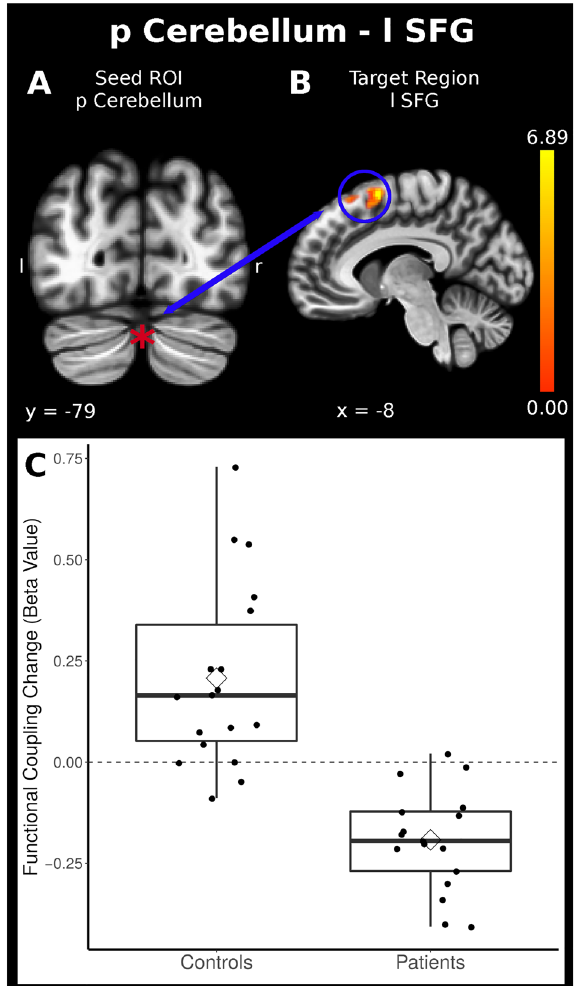
Figure 3. Task-related connectivity was reduced between the posterior cerebellar network as the seed region and the left superior frontal cortex ( P < 0.05 FWE-corrected, the coordinates are displayed in Table 2). Below are the boxplots of the Beta Values for the patients and control